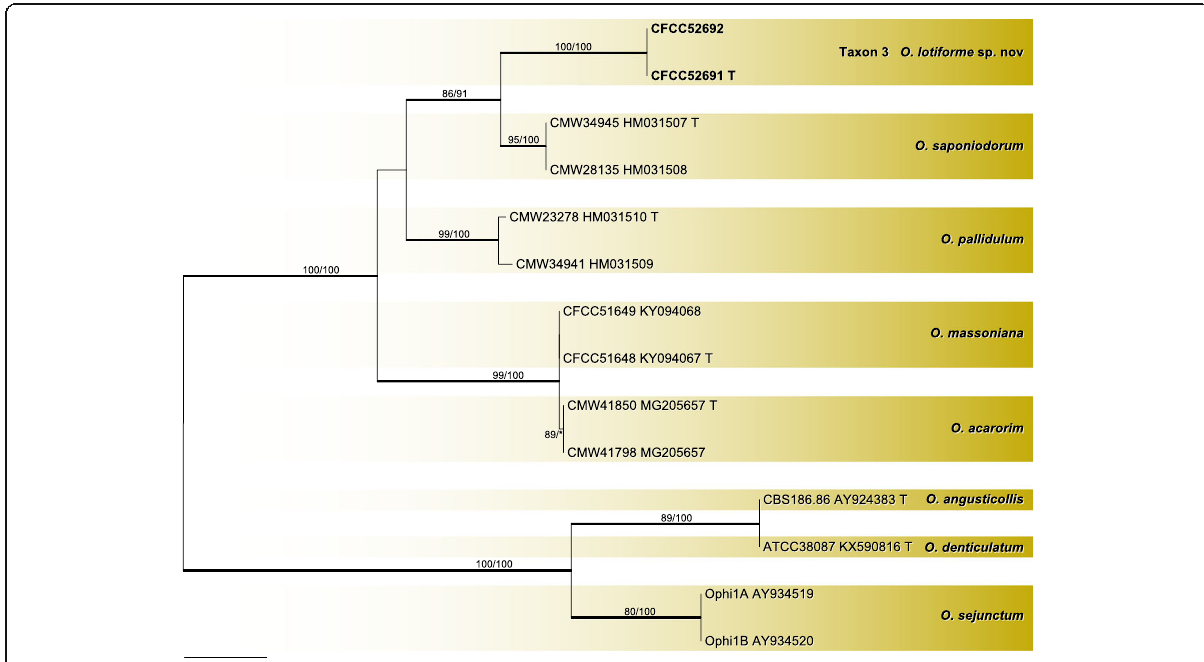
Fig. 9 ML tree of Group A generated from the ITS sequence data. Sequences generated from this study are printed in bold. Bold branches indicate posterior probability values ≥ 0.9. Bootstrap values of ML/MP ≥ 70% are recorded at the nodes. T = ex-type